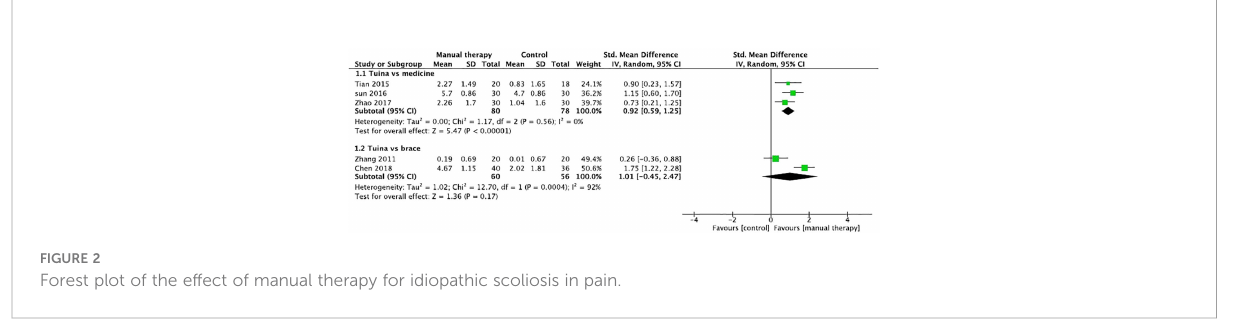
FIGURE 2 Forest plot of the effect of manual therapy for idiopathic scoliosis in pain.